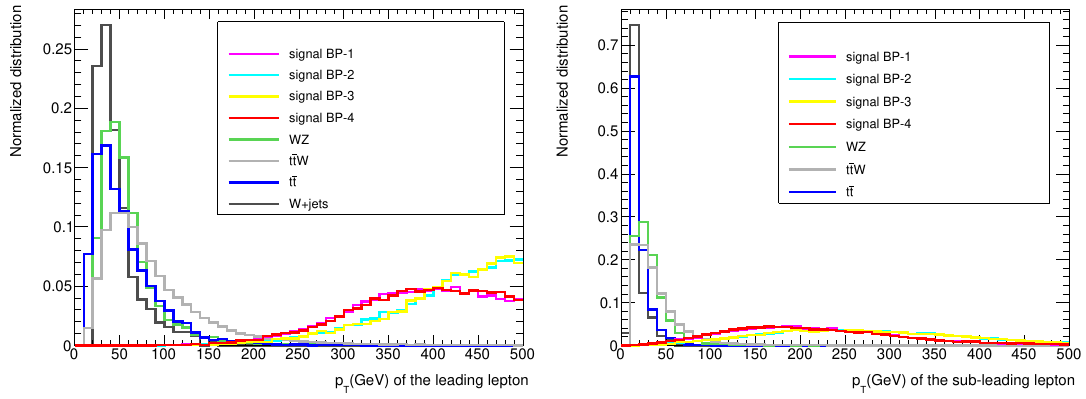
Figure 11 . Distribution of transverse momenta of the leading(left) and sub-leading(right) leptons for the four signal BPs and backgrounds in case I.